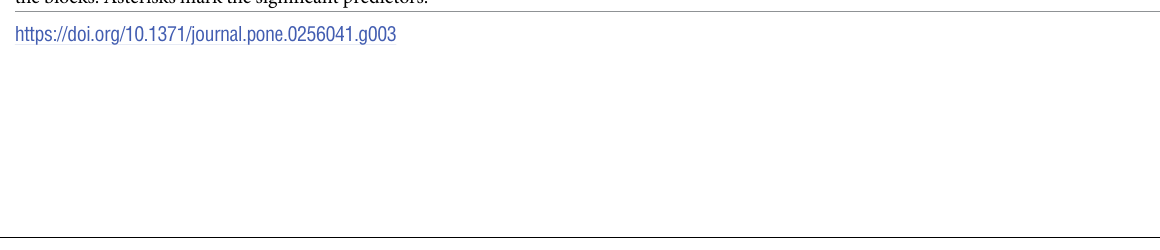
Fig 3. Plot of the odds ratios with 95% confidence intervals based on the final regression model predicting resilient vs . not resilient outcomes. On the left side ( < 1, red) there are the risk factors, on the right side ( > 1, blue) the protective factors. Different grey bands distinguish the blocks. Asterisks mark the significant